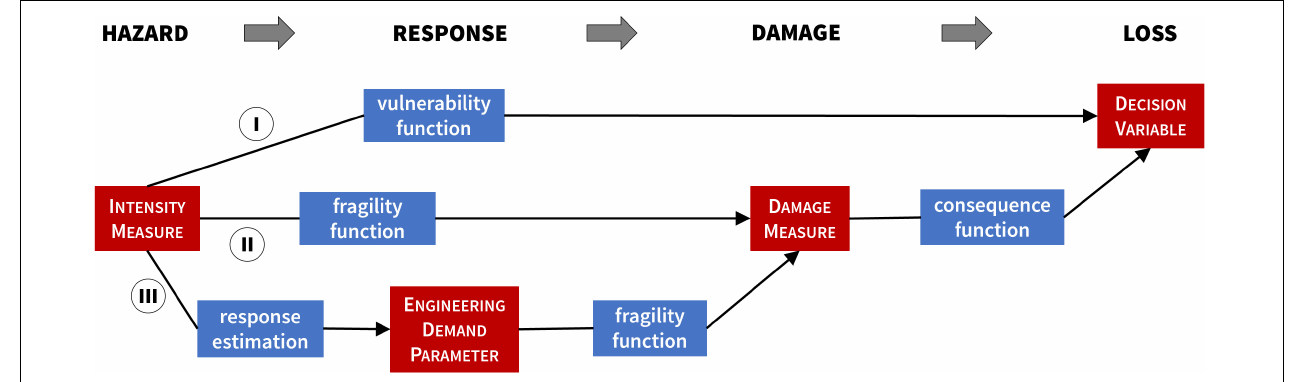
FIGURE 3 | Schematic workflows for asset performance